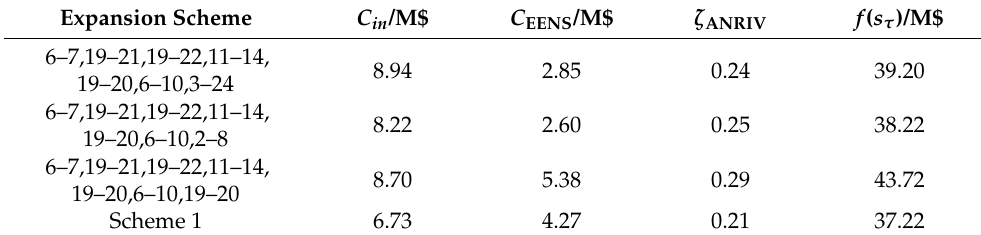
Figure 11. Q value of actions after construction of three different lines. Table 3. Comparison of indexes and costs of four expansion schemes.